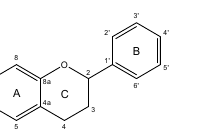
Figure 1. Structure of the flavanic core. A and B aromatic rings and C pyranic ring.